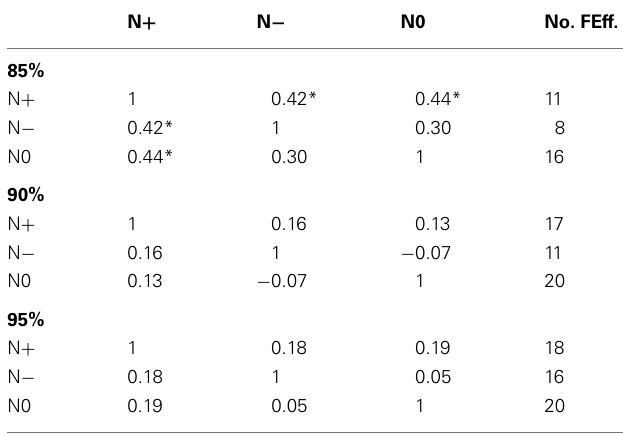
Table 1 | Comparative analysis of the results from PCA-DEA with 85, 90, and 95% of variance